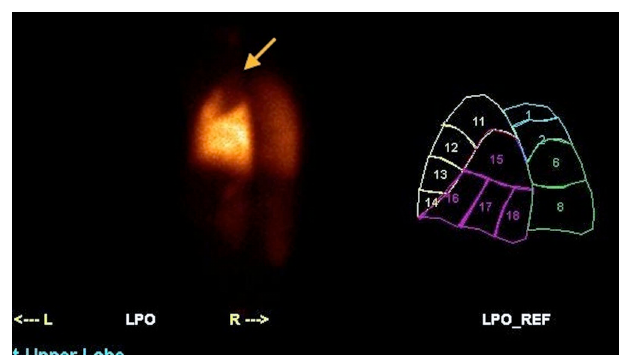
Fig. 4 - Pulmonary thromboembolism - Ventilation/perfusion scintigraphy in patient using ASA, performed two years after total cavopulmonary connection with extracardiac conduit, showing pulmonary thromboembolism at the apex of the left lung (segment 11).